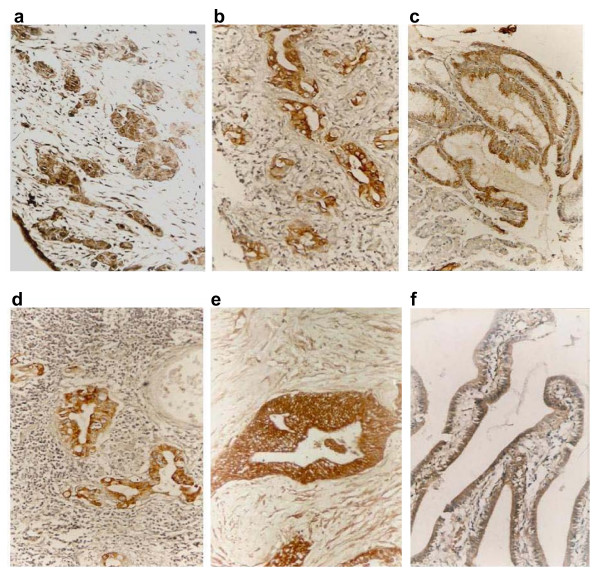
Immunohistochemical staining of p-ERK1/2 and PI3-K (original magnification 200×). p-ERK1/2 expression in peri-tumor tissues with severe atypical proliferation of gallbladder adenocarcinoma (a), in gallbladder adenoma polyps with moderate atypical proliferation (b), in chronic cholecystitis with moderate atypical proliferation (c). PI3-K staining in surrounding tissues with severe atypical proliferation of gallbladder adenocarcinoma (d), in gallbladder adenoma polyps with severe atypical proliferation pericancerous tissues (e), and in chronic cholecystitis with mild (f).